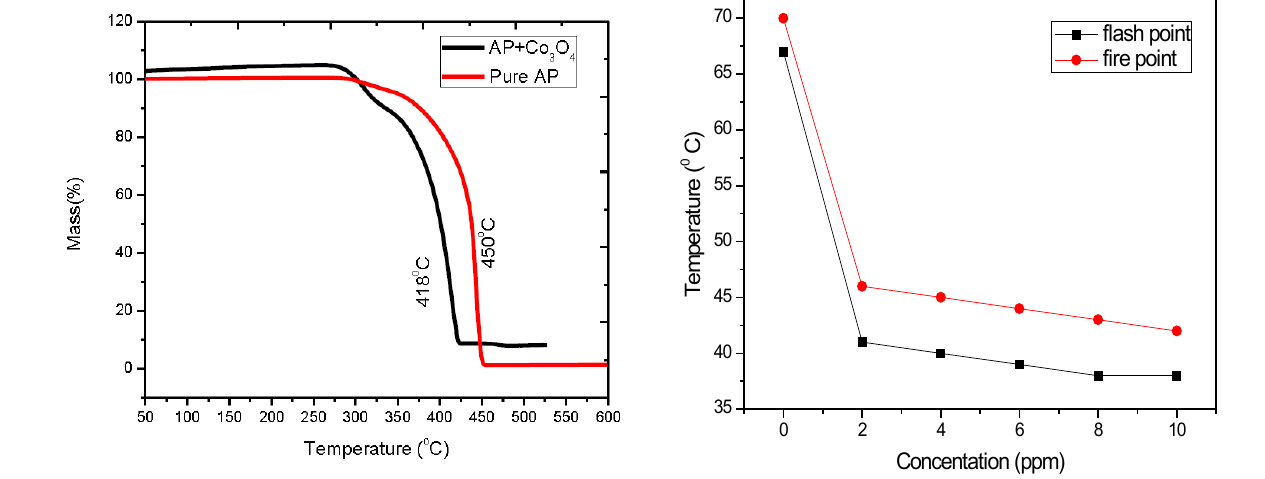
Figure 5: The TG curves for pure AP and a mixture of AP and Co flake like micro particles.